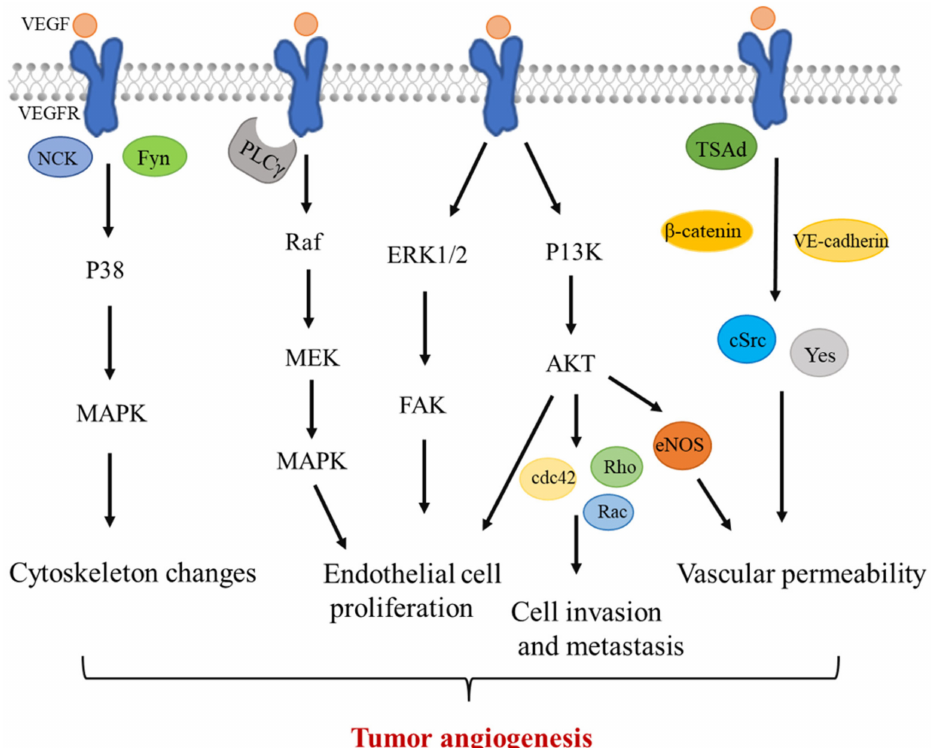
Figure 1. VEGF signaling pathway. After the VEGF level reaches the maximal concentration level at the leading edge of the vascular sprout, it binds to VEGFR and induces the migration of endothelial tip cells. Once VEGFR is activated, it leads to a series of downstream pathways. The transduction of downstream Raf-MEK-MAPK, P13K/AKT, (ERK)1/2/FAK, and other signals affects endothelial cell proliferation and survival. PI3K/Akt signaling is responsible for the expression of other molecules required for tumor cell invasion and metastasis, including Cdc42, Rho, and Rac proteins. VEGFA can activate c-Src and Yes proteins through VEGFR and phosphorylated adhesion factors, such as VE- cadherin and β -catenin, in the presence of TSAd to increase the vascular permeability. Furthermore, activated endothelial nitric oxide synthase (eNOS) affects vascular permeability by releasing nitric oxide in blood vessels. VEGFR can activate the P38/MAPK signaling pathway through Nck and Fyn binding, induce changes in the cytoskeleton, and promote tube formation in endothelial cells. VEGF, vascular endothelial growth factor; and VEGFR, vascular endothelial growth factor